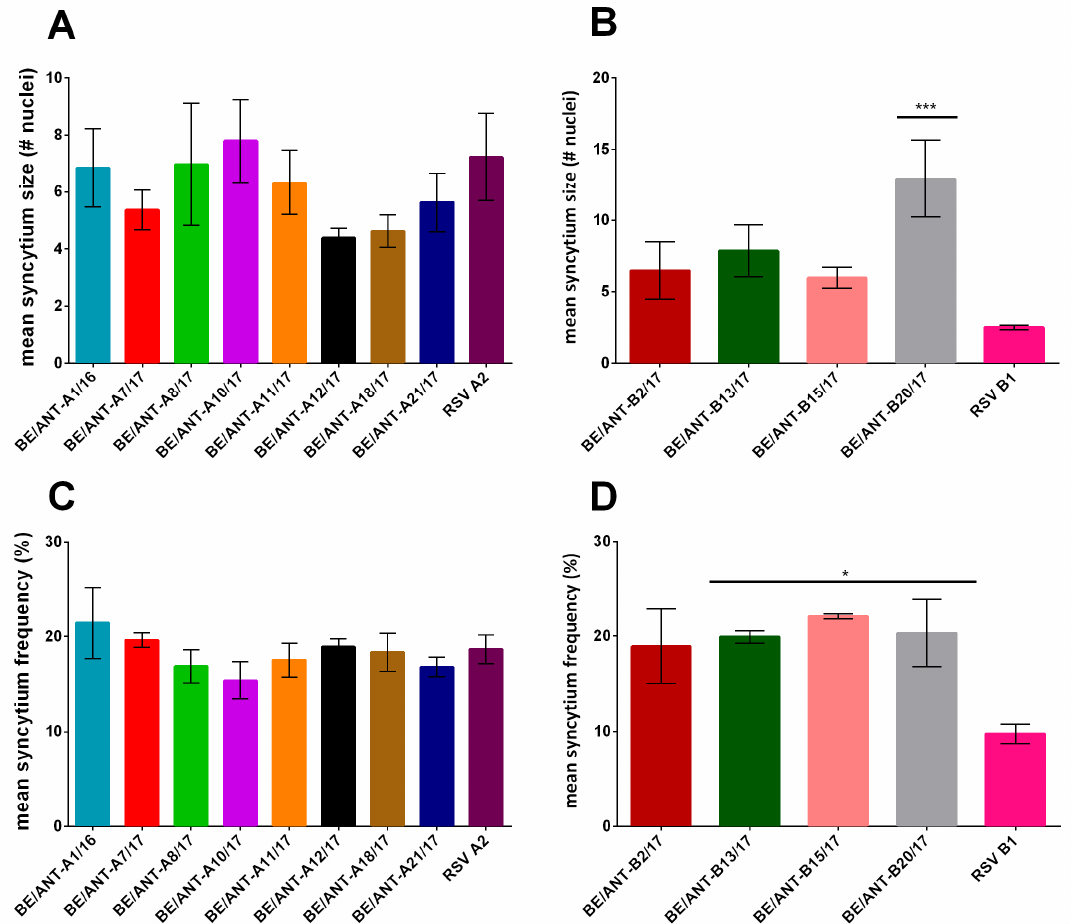
Figure 6. The capacity for syncytium formation of clinical isolates. HEp-2 cells were infected with clinical isolates and RSV reference strains A2 and B1 for 2 h, inoculum was replaced by DMEM-10 containing 0.6% Avicel ® and incubated for 48 h at 37 ◦ C. Afterwards, cells were fixed, permeabilized and stained with pAb goat-anti-RSV and AF488 donkey-anti-goat. Nuclei were visualized with DAPI and cultures were analysed with fluorescence microscopy. ( A , B ) Mean syncytium size was calculated by counting the number of nuclei in syncytia in three pictures taken at 10 × magnification. ( C , D ) Mean syncytium frequency was calculated by dividing the number of syncytial cells by the total number of infected cells. Data represents mean values ± SEM ( n = 3), significant di ff erences compared to the reference strains are indicated by * p < 0.05; *** p < 0.001 (one-way